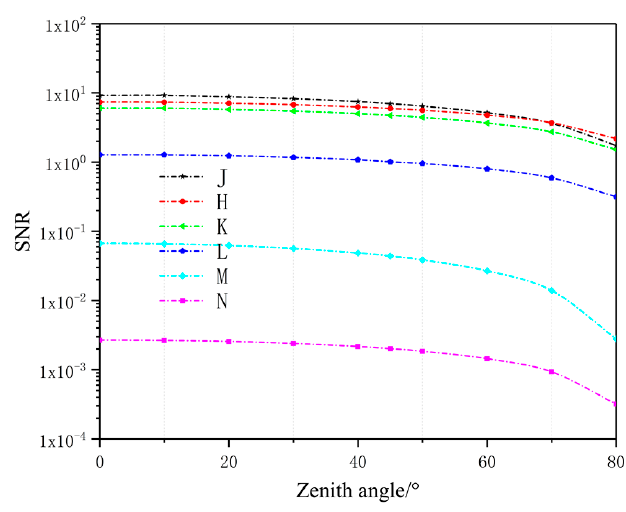
Figure 3. SNR of the target in different infrared bands.